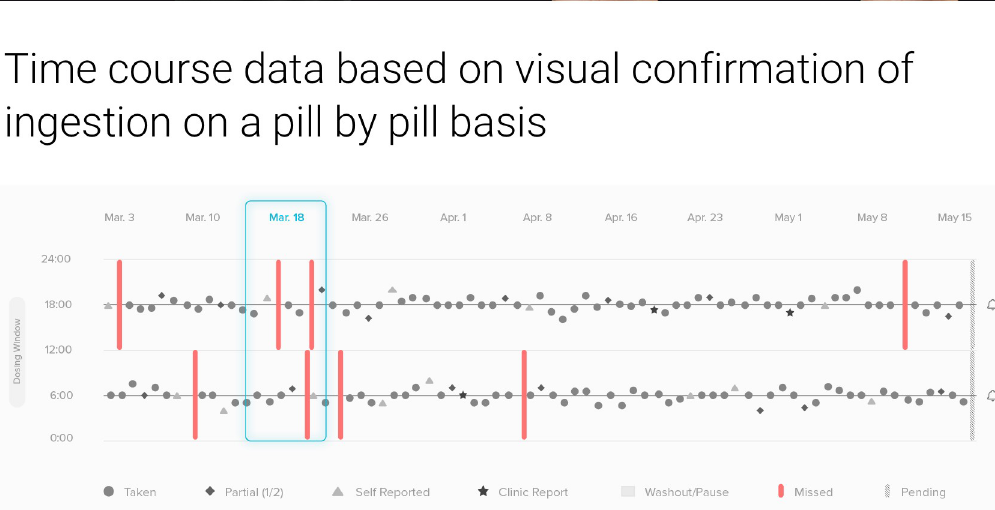
PLOS ONE | https://doi.org/10.1371/journal.pone.0254950 July 21,